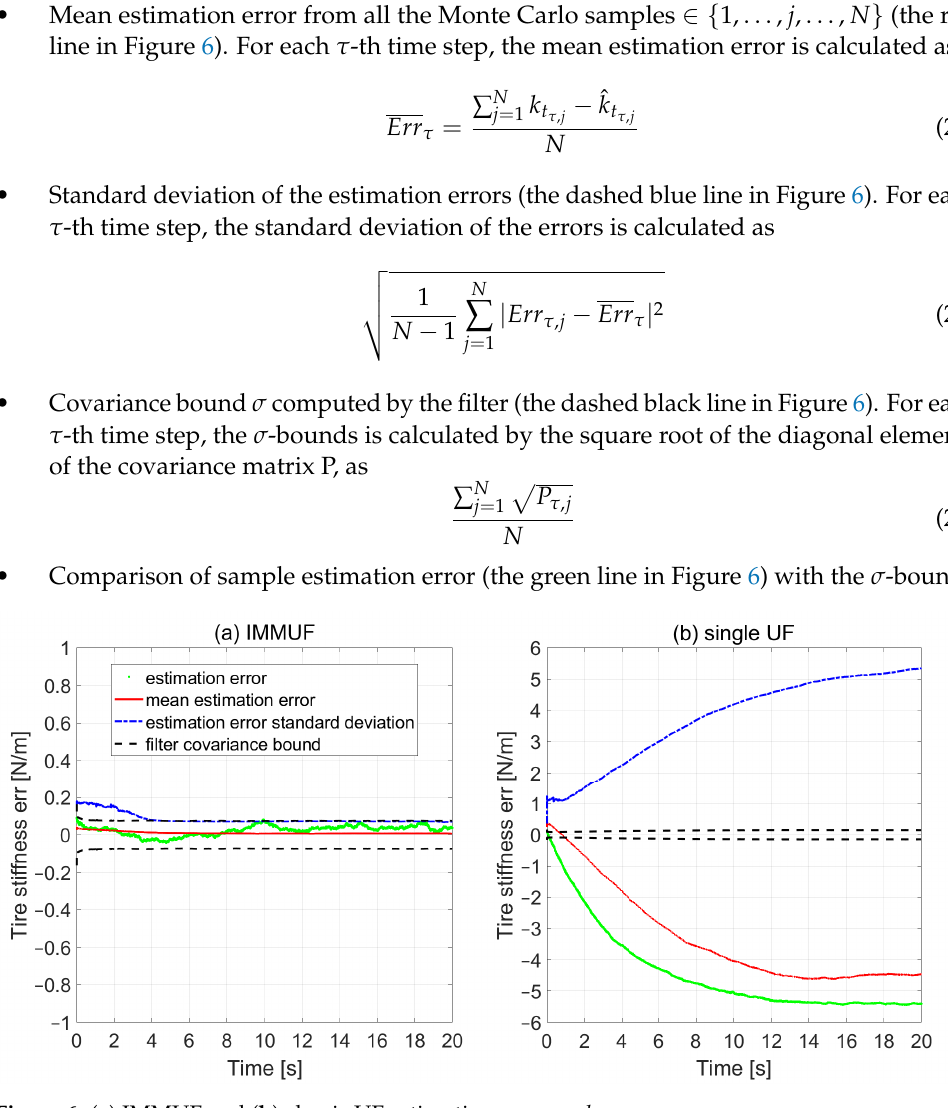
Figure 6. ( a ) IMMUF and ( b ) classic UF estimation error on k t